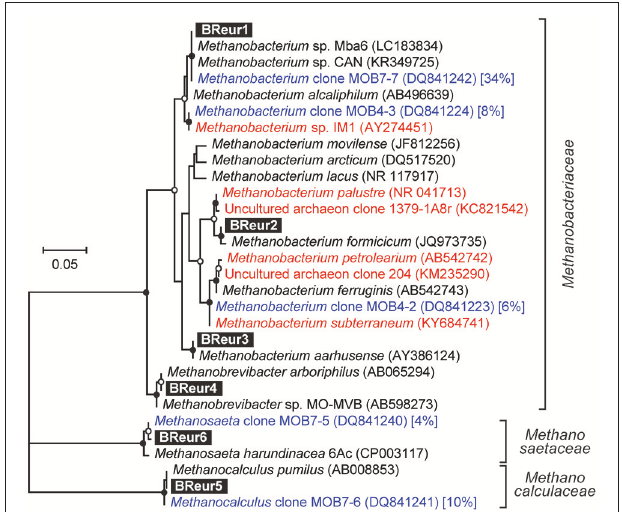
FIGURE 8 | Maximum likelihood based phylogenetic trees showing positions of major DIET-related Euryarchaeota OTUs representing cathodic electromethanogenic microbial populations. Branch points supported with bootstrap values (100 trials) of > 90% are indicated with closed circles, while those between 70 and 90% are indicated with open circles. Accession numbers of reference sequences are indicated in parentheses. Euryarchaeal clones observed in different formation water from Minami-Kanto gas field (Mochimaru et al., 2007) were highlighted by blue letter, and the relative frequency within the formation water (%) was described after accession number. Methanobacterium clones observed in other electromethanogenic community or iron-oxidizing methanogenic community were highlighted by red